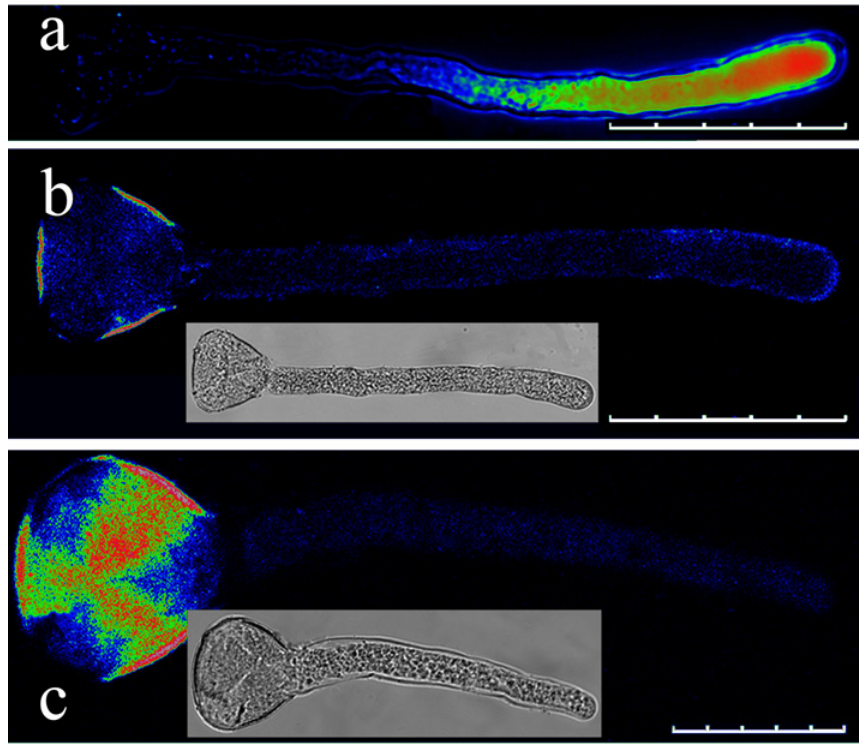
(c) Pollen tube after addition of 1 mM EGTA during fluo-4/AM loading. Scale bars: 100 μ m (a), 60 μ m (b) and 30 μ m